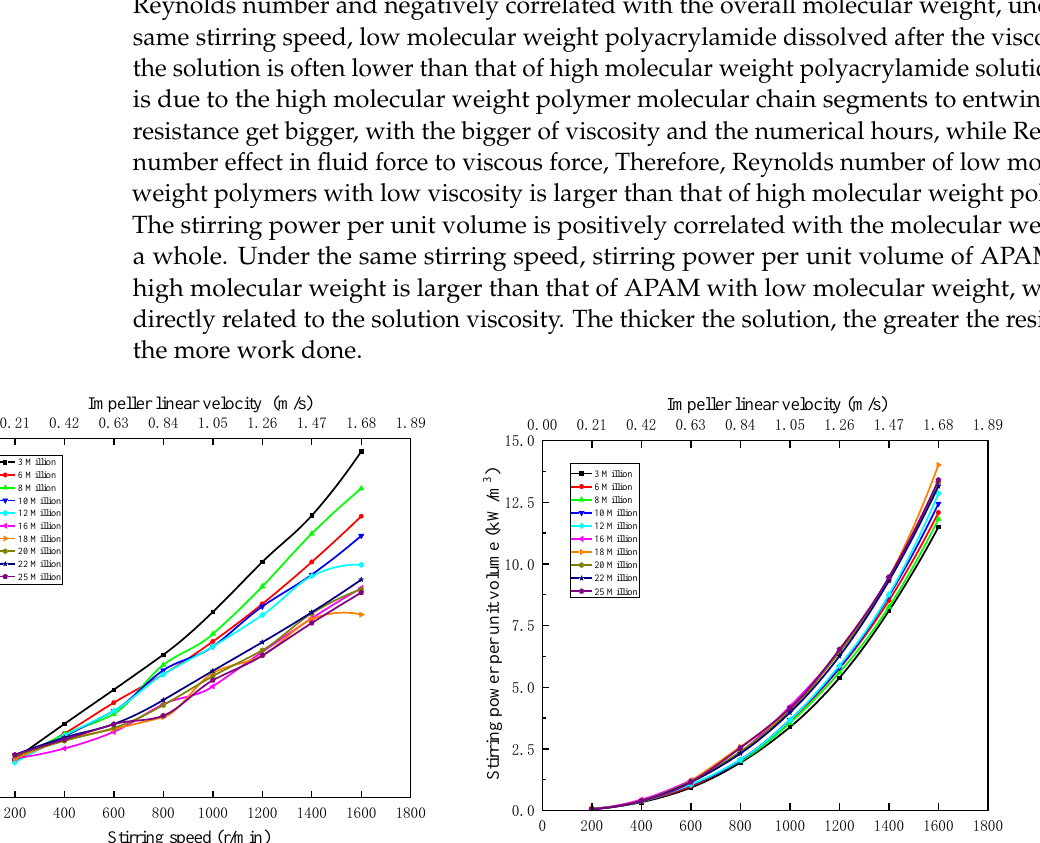
Figure 4 indicate that when the stirring speed ranges from 200 to 1600 r/min, the cor- responding impeller linear velocity ranges from 0.21 to 1.68 m/s, both power number and stirring time are negatively correlated with stirring speed. Power number is positively correlated with the molecular weight. At the same stirring speed, power number of low molecular weight APAM is lower than that of high molecular weight APAM. Stirring time is positively correlated with molecular weight as a whole. At the same impeller linear velocity, flocculants with relatively high molecular weight need longer stirring time than flocculants with relatively low molecular weight. Flocculants with high molecular weight have a longer molecular chain and higher viscosity than flocculants with low molecular weight, so the stirring time is longer.